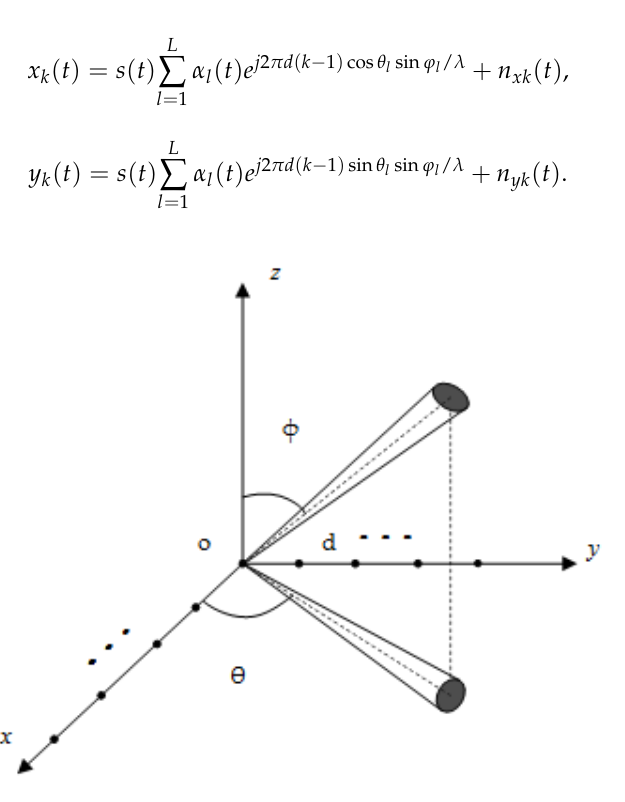
Figure 1. The L-shape arrays configuration.